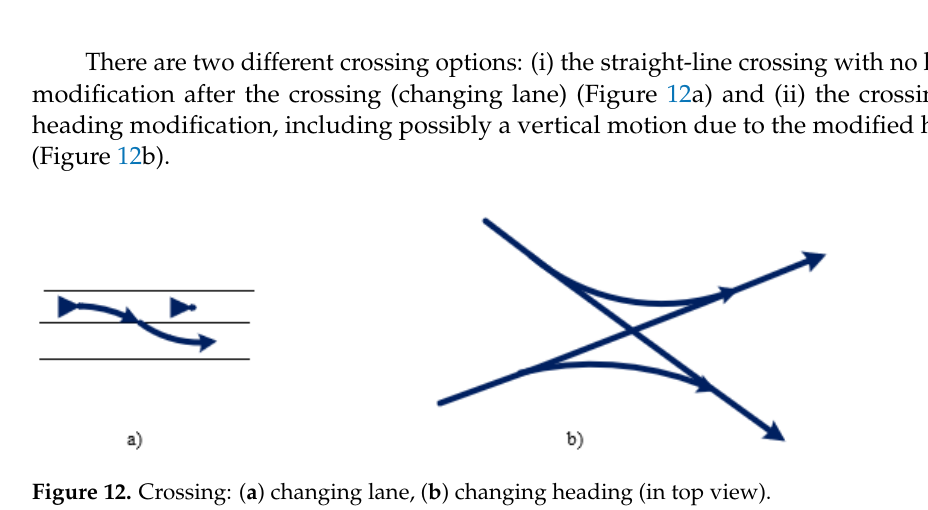
Figure 11. Changing altitude in the same direction: ( a ) with a straight flight, ( b ) with coordinated turn.